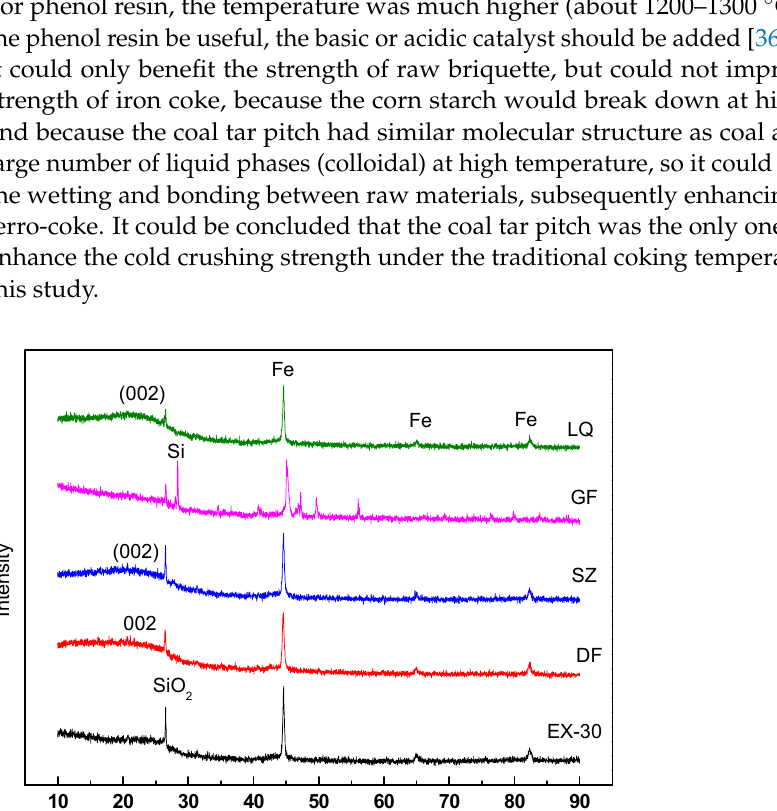
Figure 14. XRD of ferro-coke with different binders. Different amounts of coal tar pitch in the raw coal of QE3 were used to explore the optimal addition amount of coal tar pitch. It could be found that large pores appeared on the surface of all the ferro-coke, as shown in Figure 15, and the 5%LQ and 15%LQ have more pores than 10%LQ.